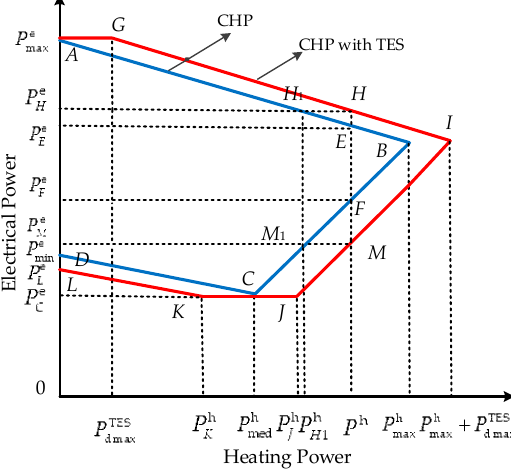
Figure 1. Heat-electricity relationship of CHP unit with TES.